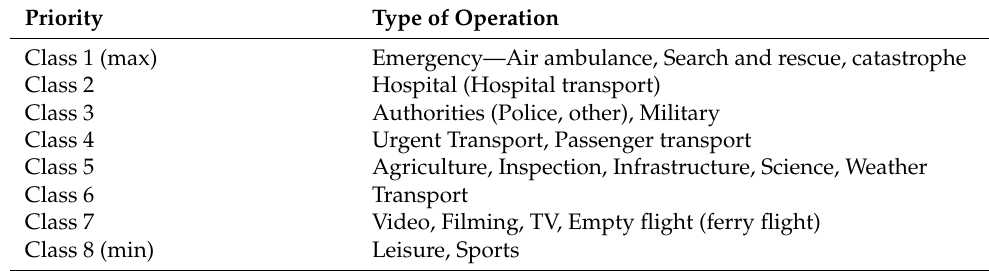
Table 1. Prioritization proposed in U-space, depending on the type of